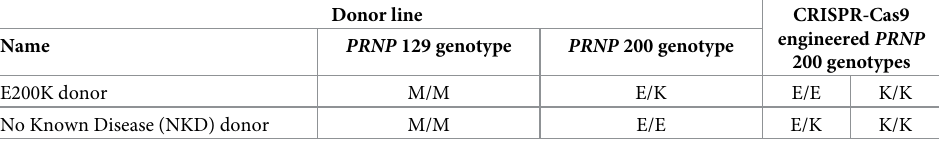
Table 1. iPSC CRISPR-Cas9 engineered